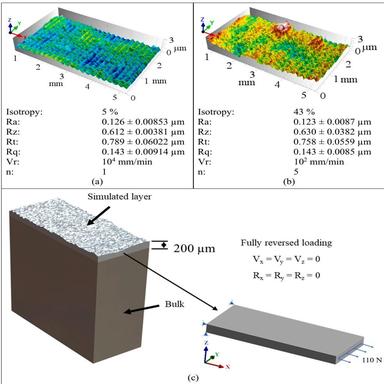
Initial conditions for simulating fatigue crack initiation: (a) anisotropic surfaces, (b) isotropic surface and (b) simulated layer.